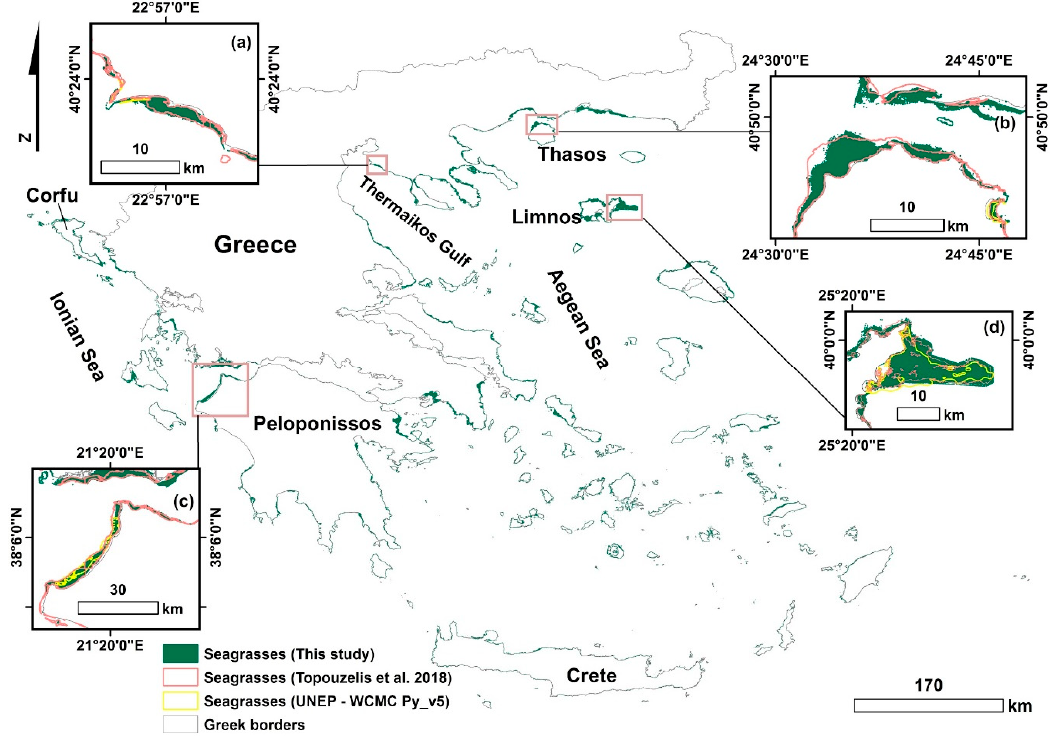
Figure 5. Distribution of seagrasses in the Greek Seas. ( a ) Thermaikos Gulf, ( b ) Thasos Island, ( c ) NE Peloponissos, ( d ) Limnos Island. Inset maps contain results from [13] and [35] for reference and further validation of our results. All panels are in GCS WGS84 World Geodetic System.